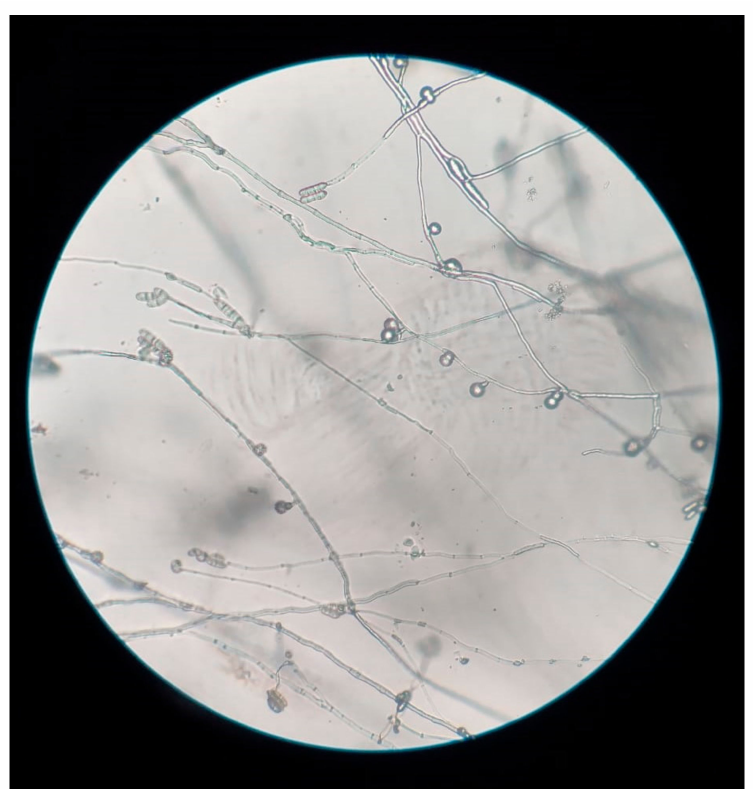
Figure 3. Slide culture of Fusarium lichenicola : Elongate conidiophores with terminal cylindrical